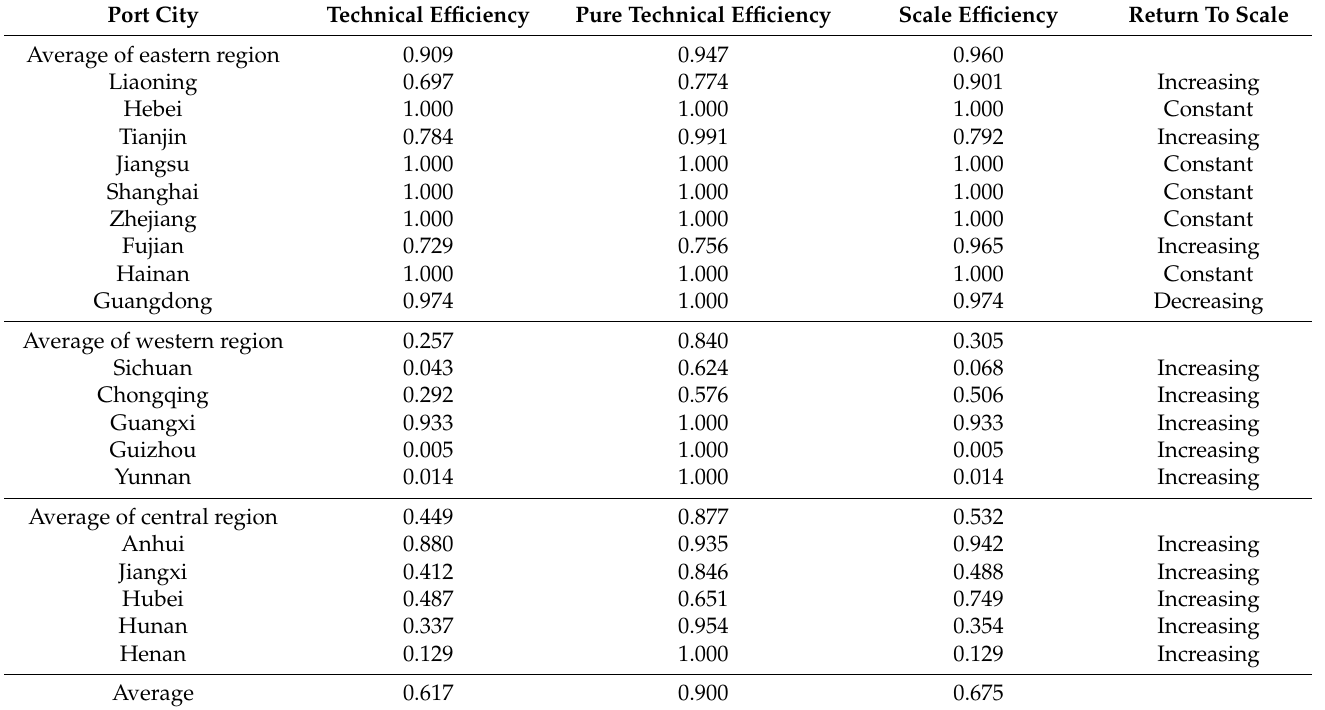
Table 4. The results of the third-stage